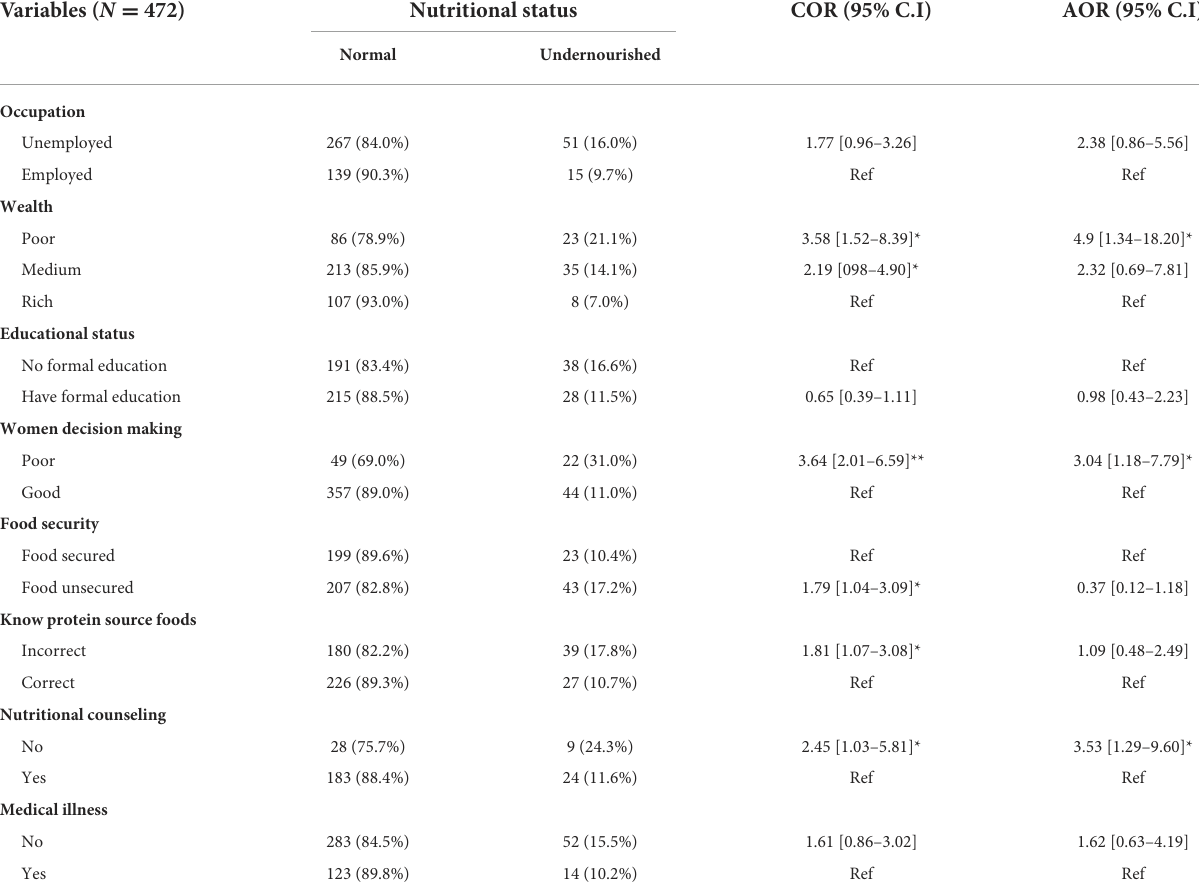
TABLE 5 Binary and multivariable logistic regression analysis showing the association of undernutrition among pregnant women attending ANC service in East Shoa zone, Ethiopia, from June to August